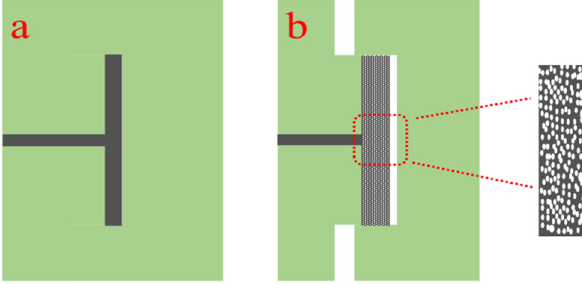
Figure 11: The schematic of the foaming process with adjustable volume: ( a ) injection process and ( b ) open mold.